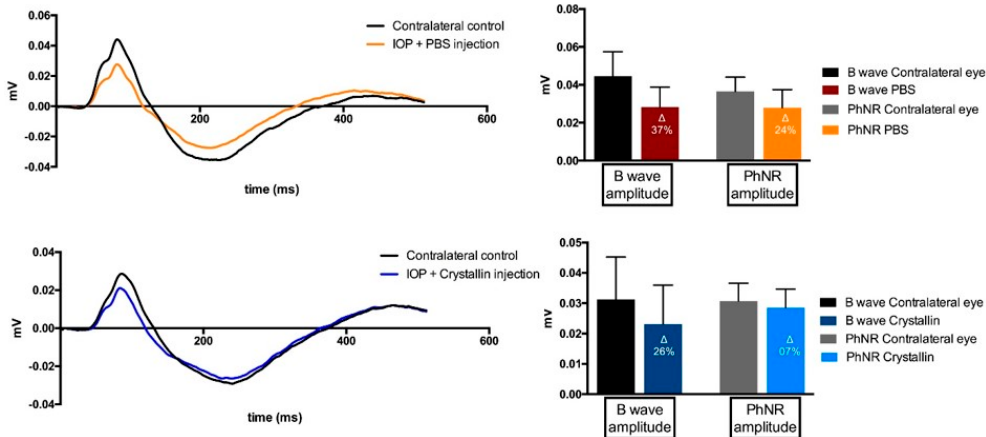
Figure 4. Pattern of the ganzfeld photopic electroretinogram analysis. ERG results showed considerable aberrances in the B-wave and photopic negative response (PhNR) between contralateral control eyes and experimental glaucoma eyes. However, the deviance to the respective control eyes seems much higher in PBS-injected eyes than in α -crystallin B injected eyes ( n = 11, mean ± SD). The millivolt decrease is defined in percentaged change ( ∆ = % change).